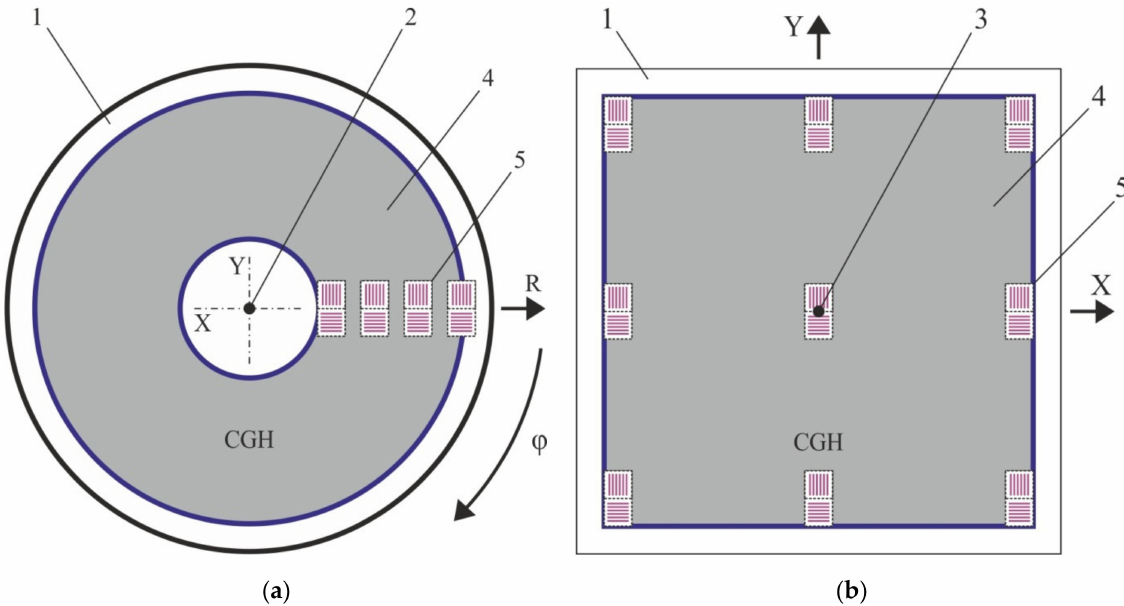
Figure 7. Layout of two-coordinate marks for writing systems: circular ( a ); X-Y ( b ). 1—optical substrate, 2—axis of rotation of the optical substrate, 3—origin of coordinates for X-Y laser beam positioning system, 4—CGH, 5—small window areas with coordinate